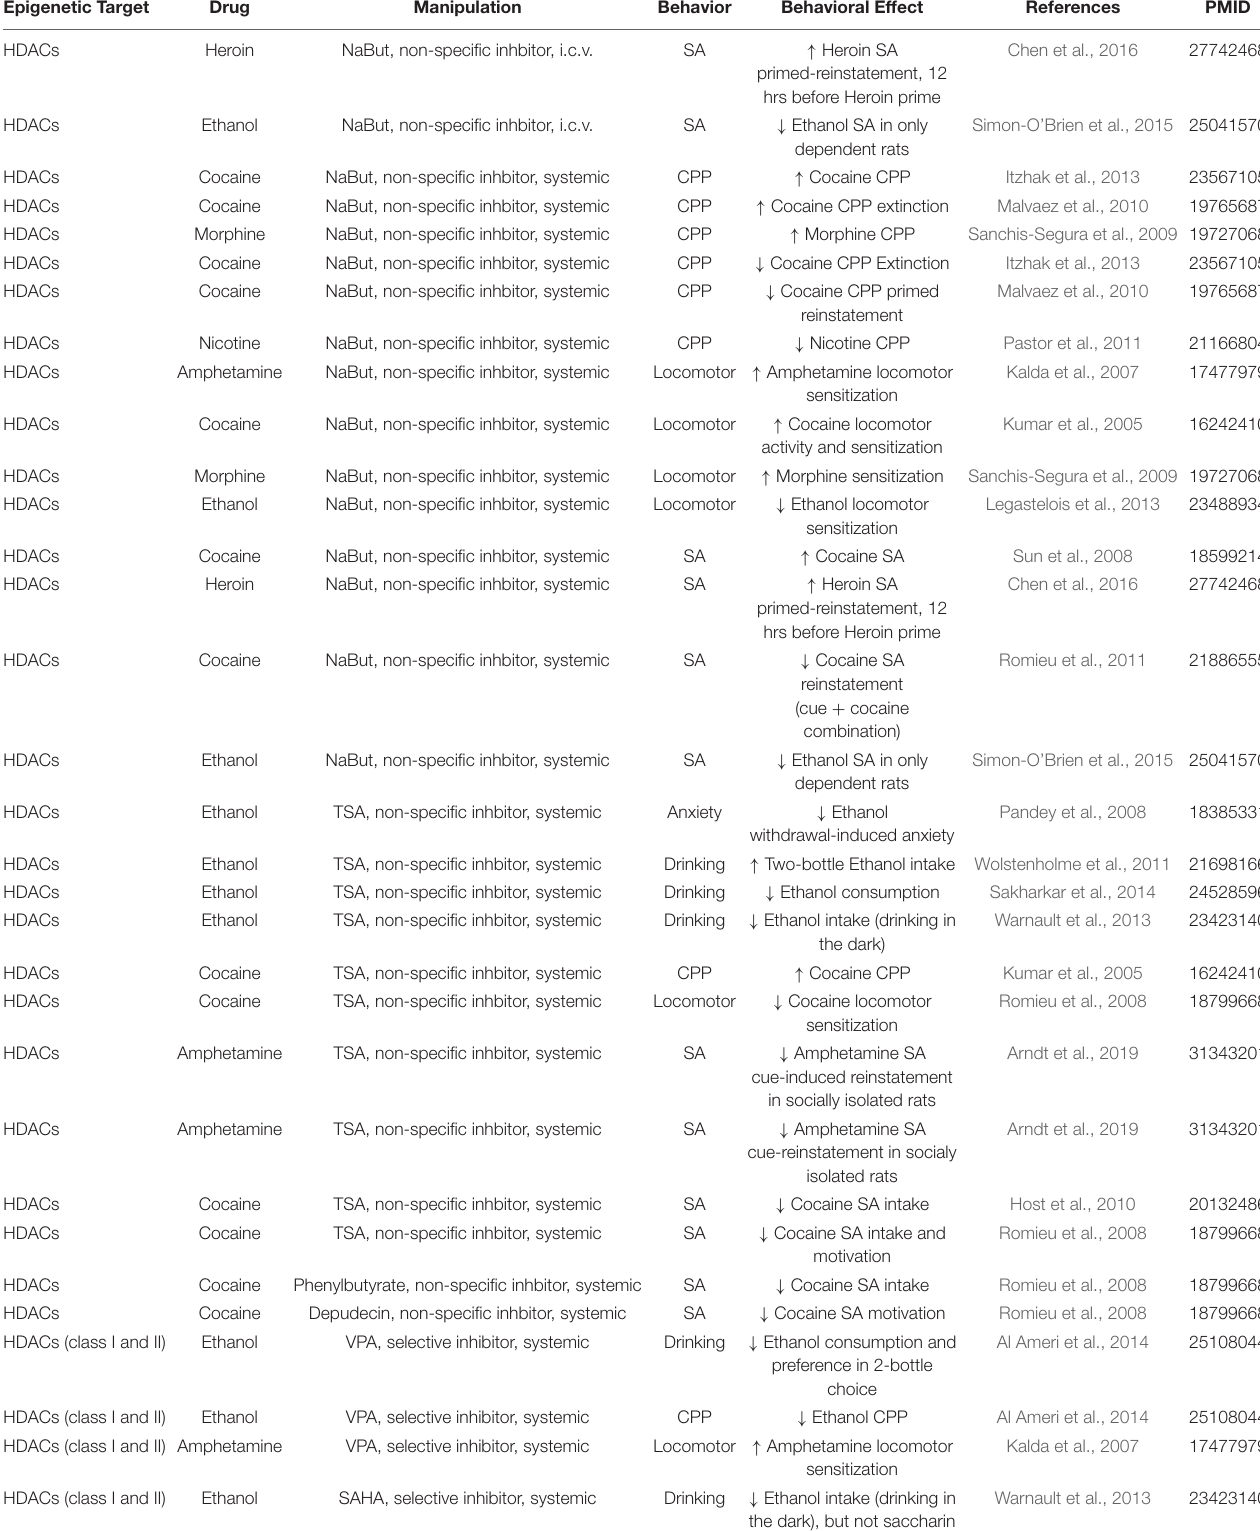
TABLE 4 | Effects of systemic inhibitors of epigenetic regulators on drug-related behaviors. Epigenetic